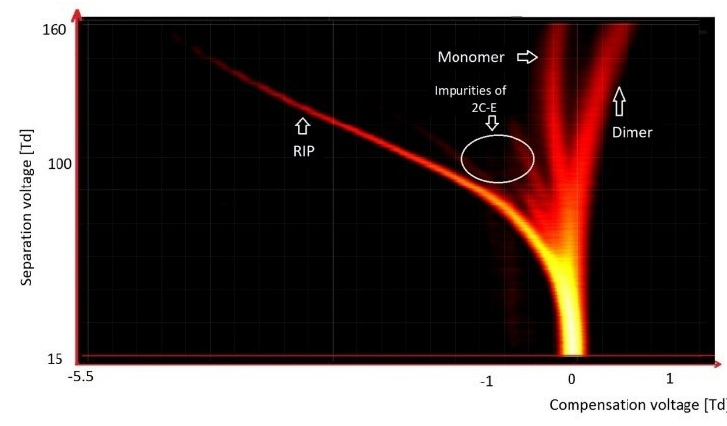
Figure 15. DMS spectrogram of 2C-E (phenylethylamine derivative).